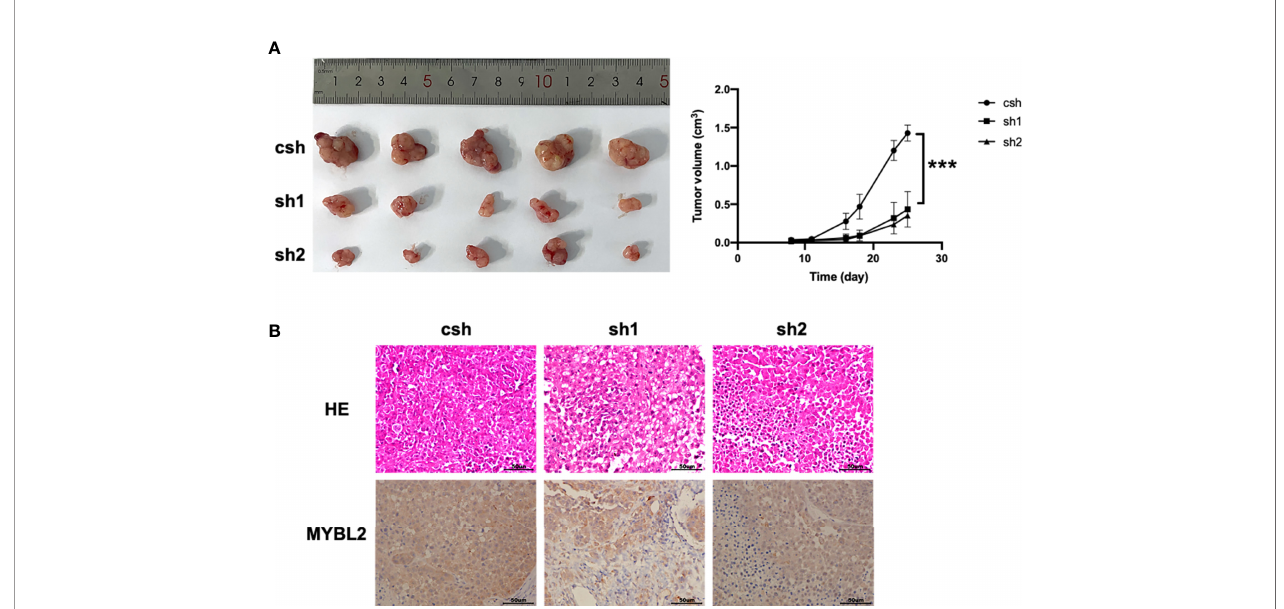
FIGURE 3 | MYBL2 promotes tumor growth and progression in xenograft mice. Twenty- fi ve days after subcutaneous inoculation of melanoma cells, tumors were removed, and diameters were measured ( n = 5/group) ± standard deviation (SD). (A) Subcutaneous tumors generated in BALB/c-nu/nu mice, with MYBL2 KD-transduced A2058 cells. (B) Histological analysis of 25-day-old subcutaneous tumors after H&E and IHC staining for MYBL2. Magni fi cation × 200. *** p <